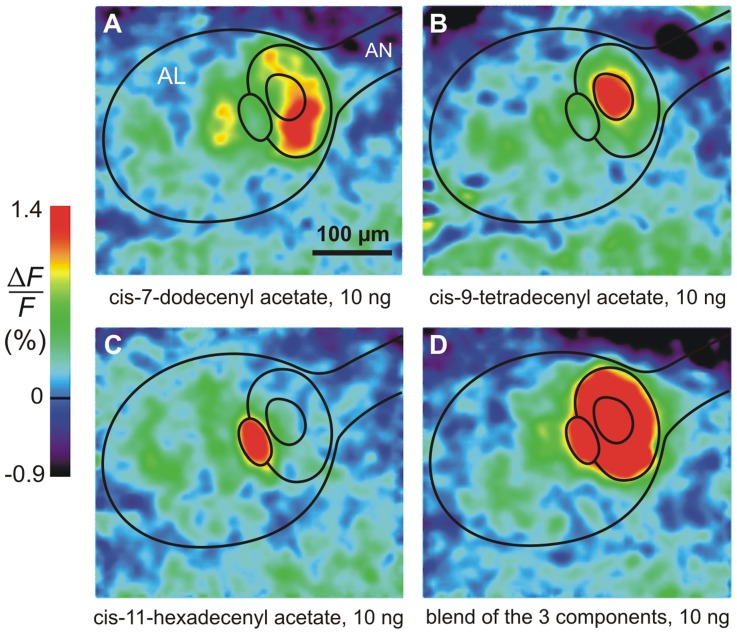
Ca2+ imaging shows that each pheromone component activates a single glomerulus in the MGC.(A) The main pheromone component activates the cumulus only. (B, C) The two secondary components activate two neighboring glomeruli. (D) The blend of the 3 components in the behaviorally most efficient ratio 4∶1∶4 activates the whole MGC. Outlines of antennal lobe (AL), antennal nerve (AN) and the 3 main subdivisions of MGC are shown.